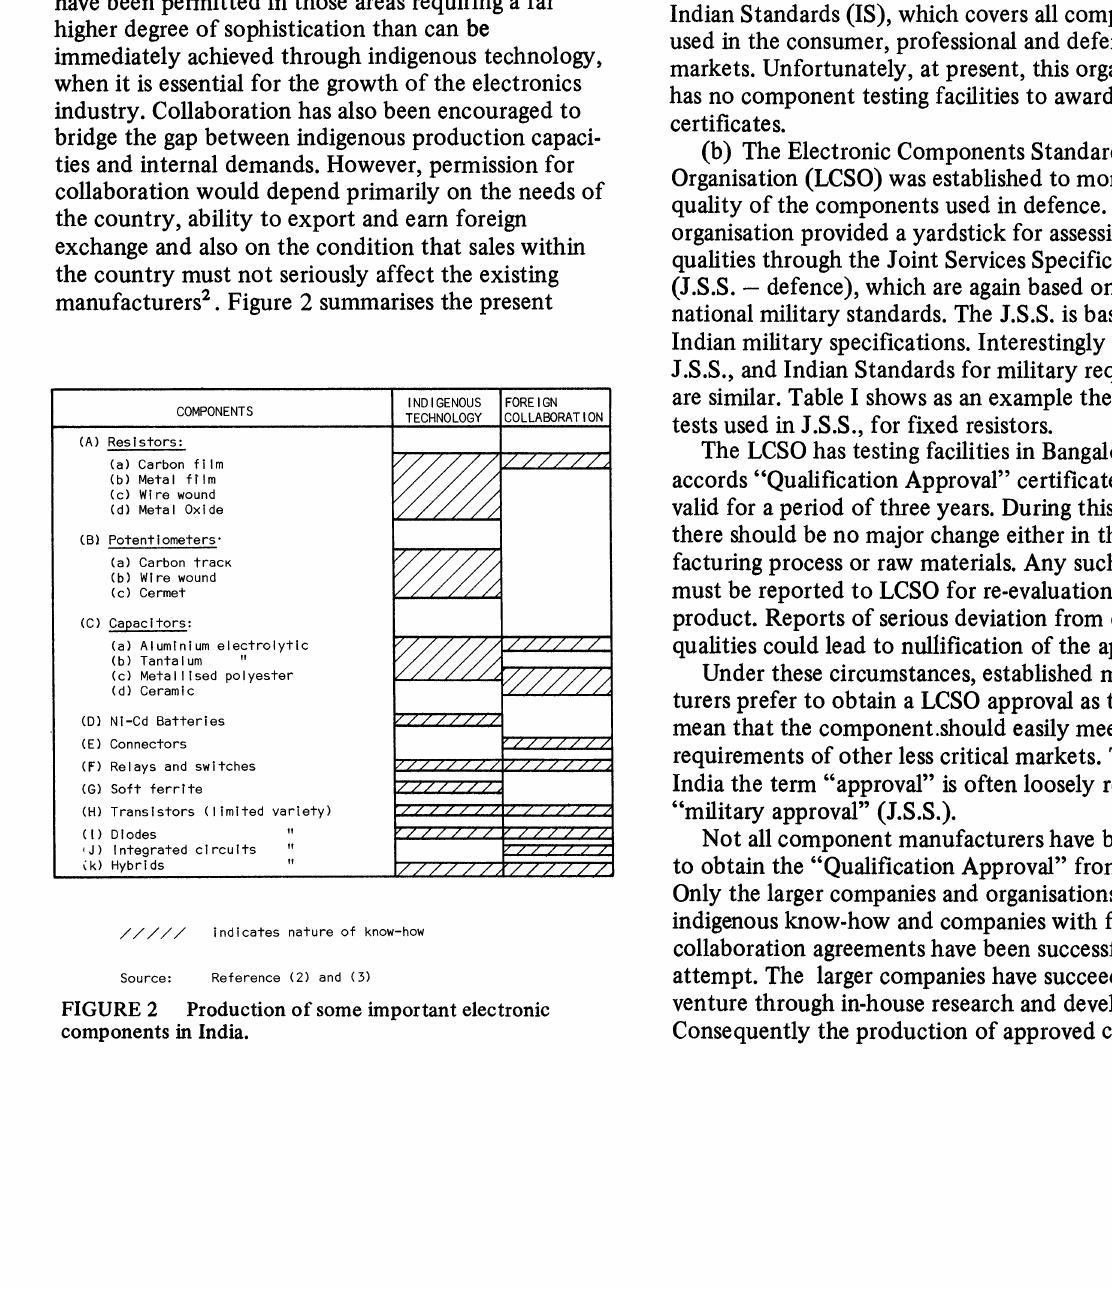
Production of some important electronic components in